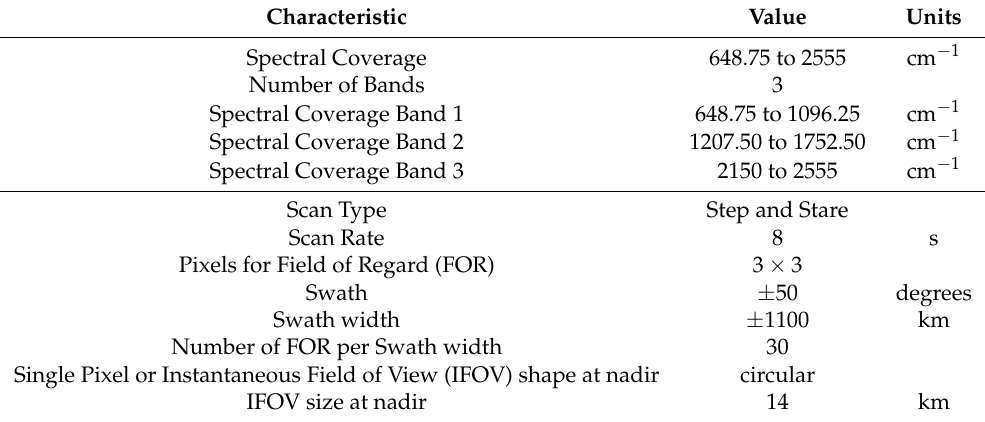
Table 2. CrIS instrument and scanning